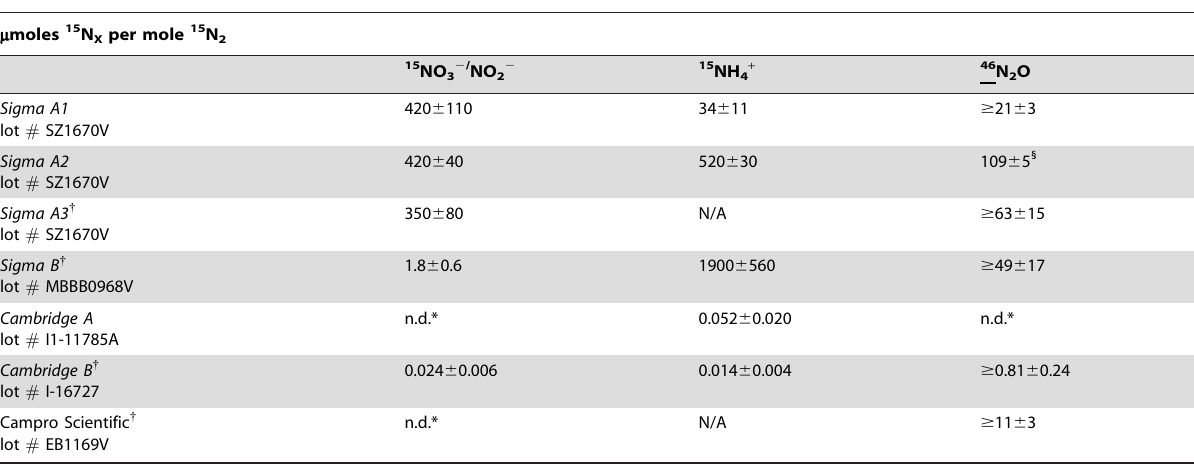
Table 1. The quantity of 15 N-labeled contaminants detected relative to 15 N 2